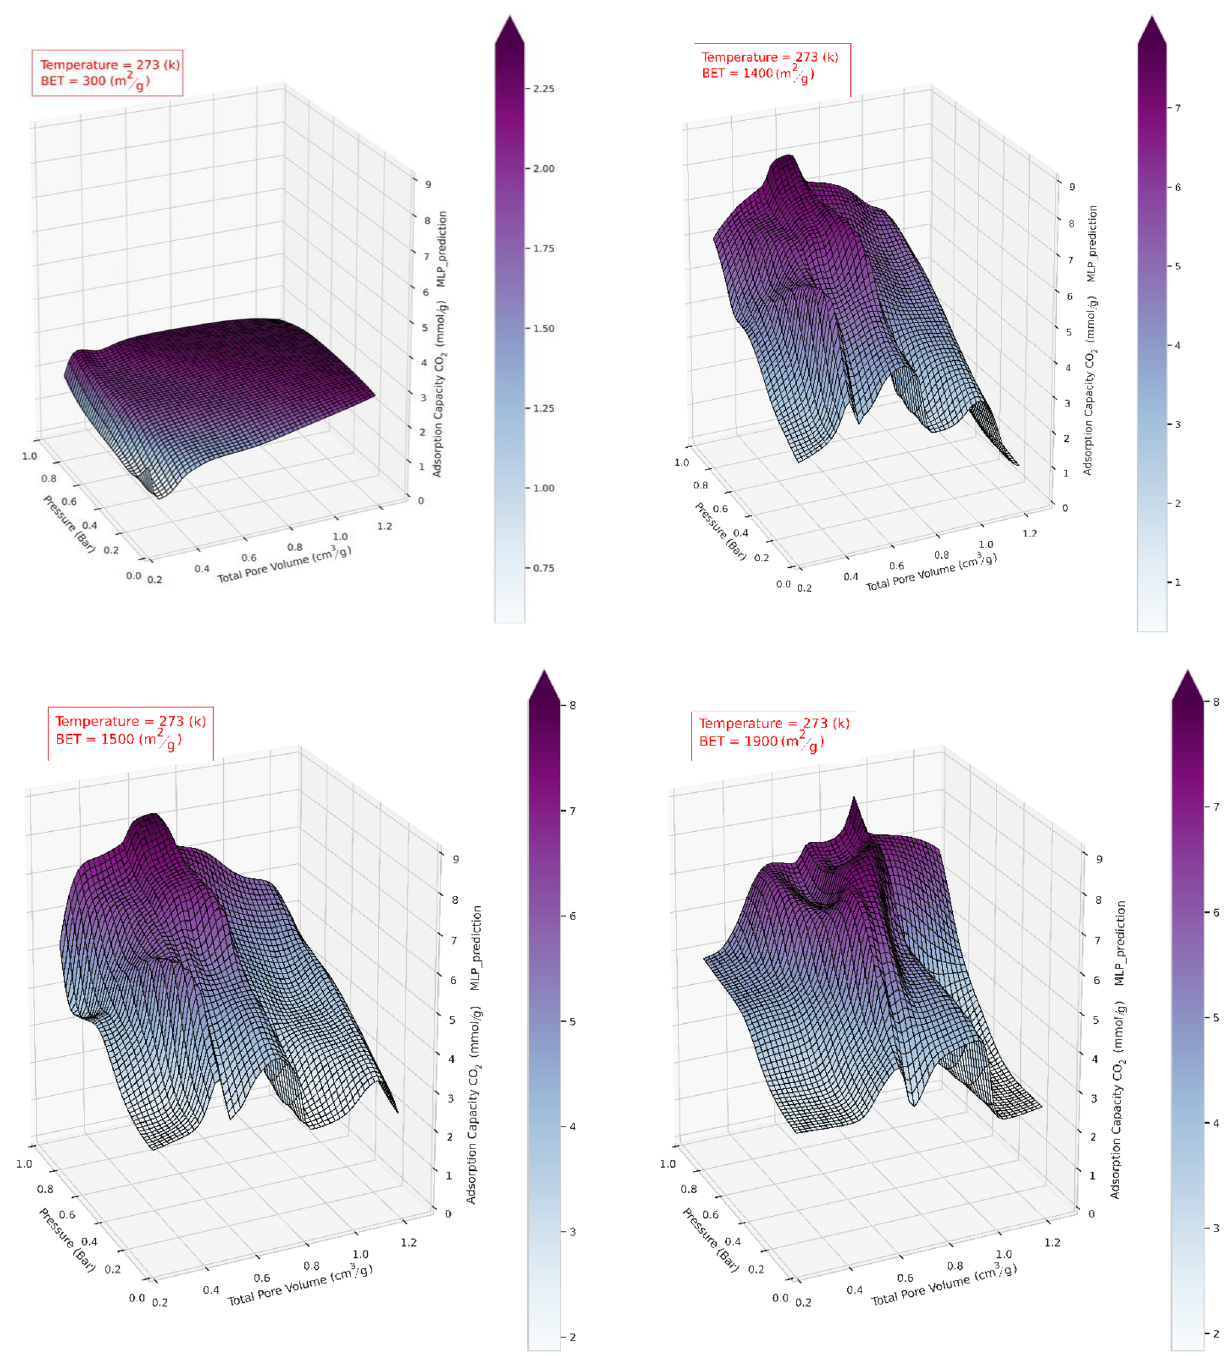
Figure 13. 3D response surface plots generated by ANN-MLP model. Total pore volume and pressure versus adsoption capacaity at various temperatures and BET